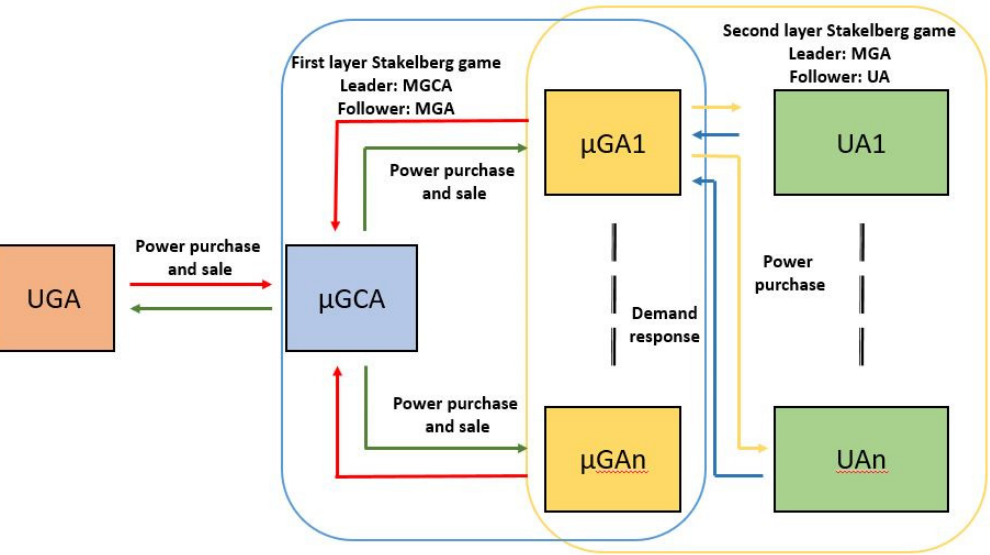
Figure 2. Communication between different layers based on the power exchange and game theory model.